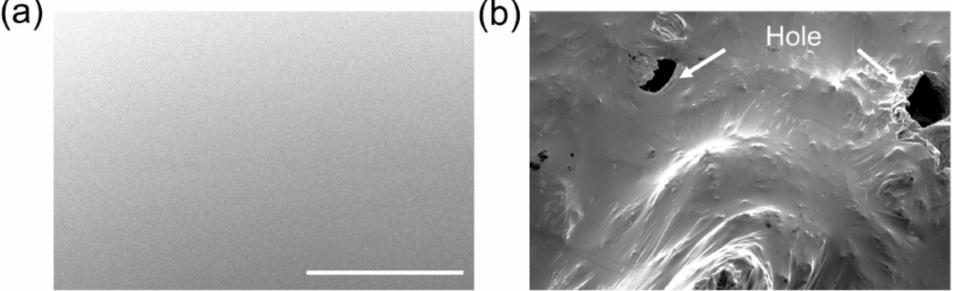
Figure 1. The morphology of ( a ) the pure liquid metal and ( b ) oxidizing liquid metal, and the scale bar is 100 µ